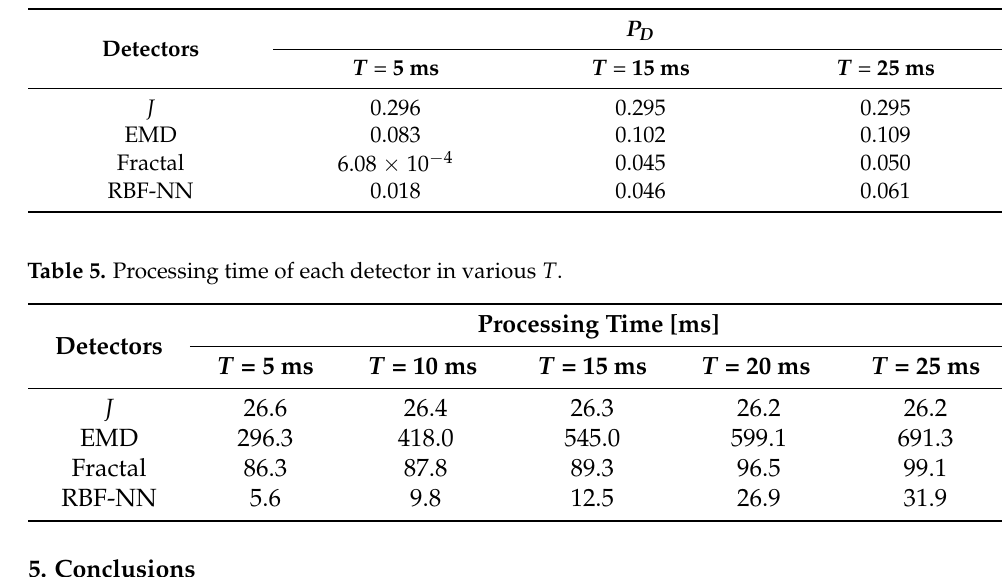
Table 4. P D of detectors in various T at P FA = 10 − 3 .